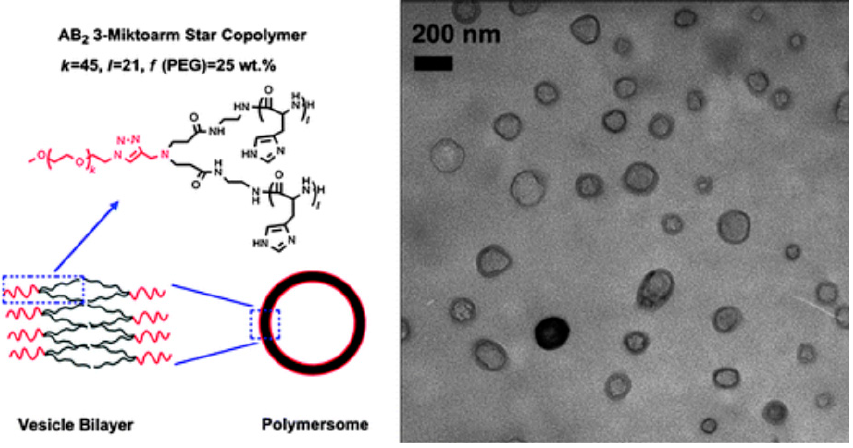
Figure 5. Cartoon schematic (left) and comparative TEM micrograph (right) of a polymersome assembled from a PEG-PHis 2 miktoarm star polymer with emphasis on its hydrophobic bilayer. Reprinted with permission from reference [43] . Copyright 2012 Royal Society of Chemistry.